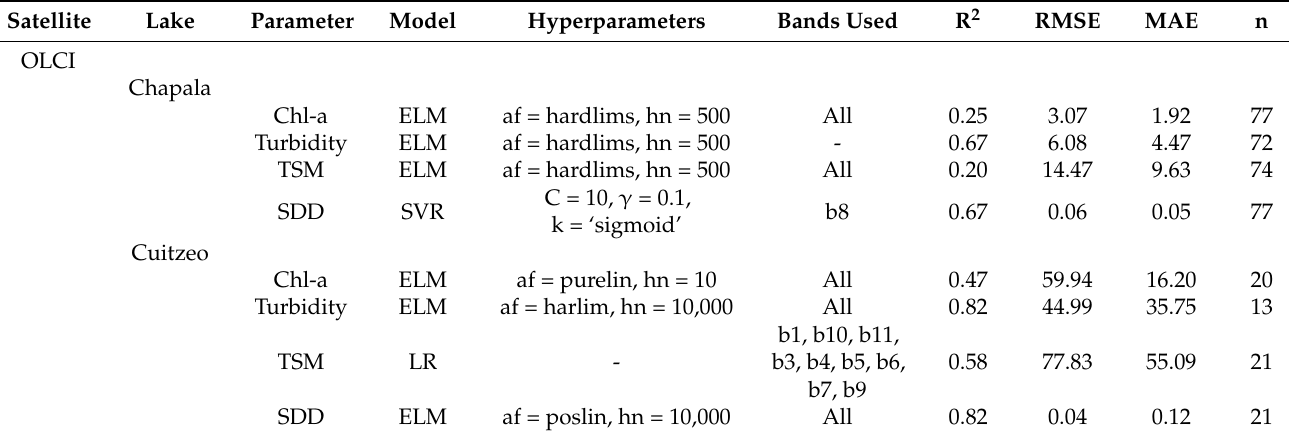
Table A5. OLCI Model validation and predictive capability results for all datasets including coefficient of determination (R 2 ), root mean square error (RMSE), mean absolute error (MAE), and the number of samples (n). Satellite Lake Parameter Model